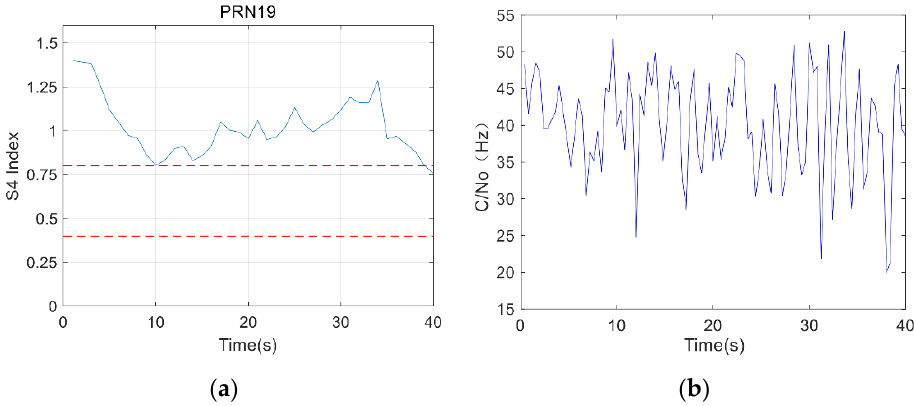
Figure 11. Variation diagram of S 4 index and C / N 0 of Brazil data on 27 February 2014; ( a ) S 4 , and ( b ) C / N 0